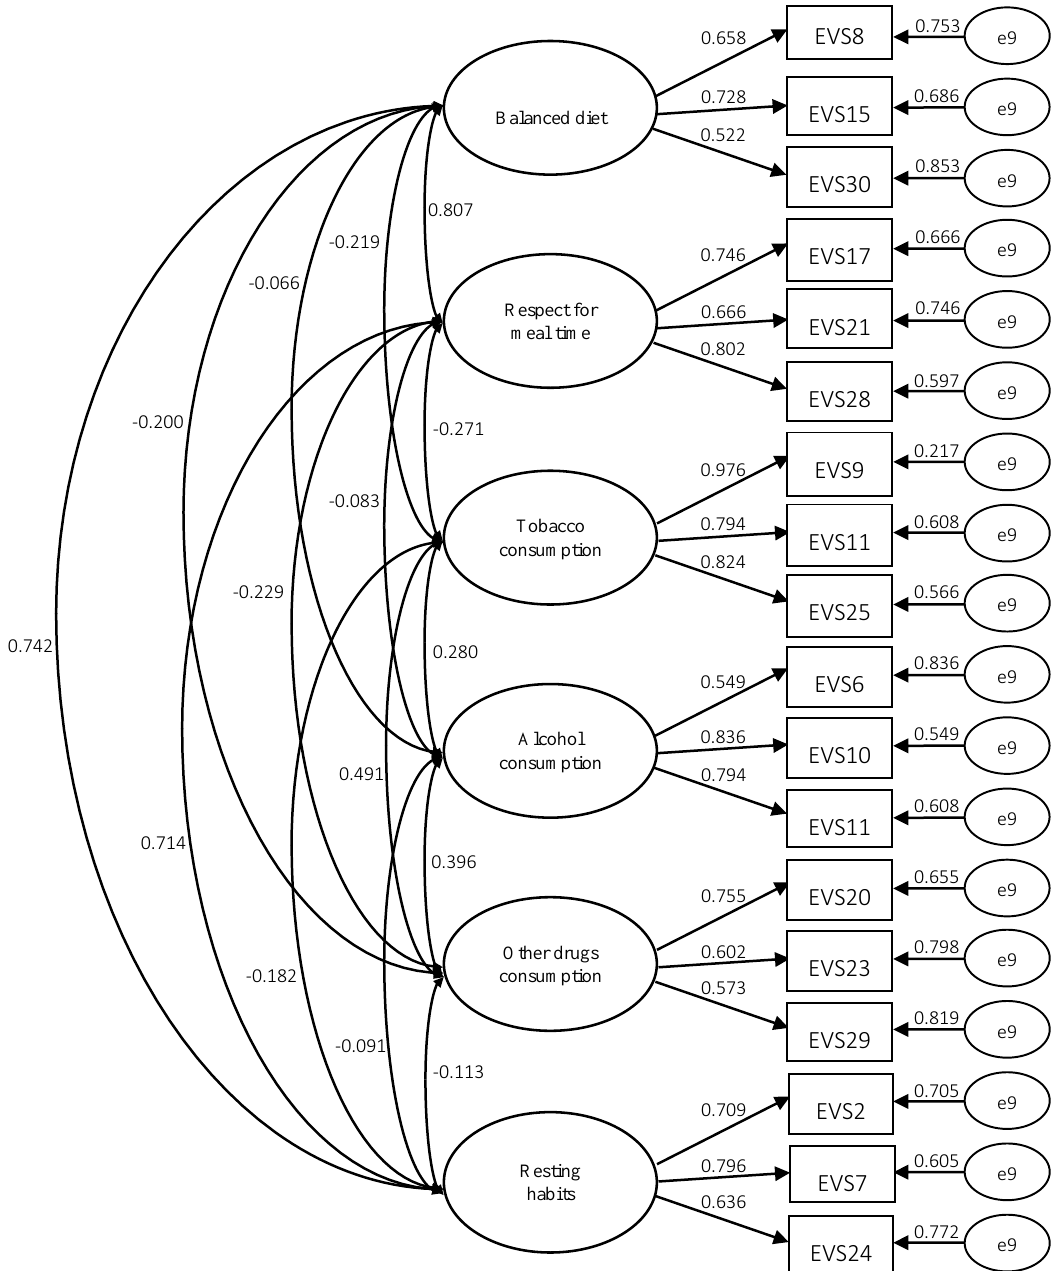
Figure 1. Structural model of the adapted version of the Healthy Lifestyle Questionnaire (EVS II).